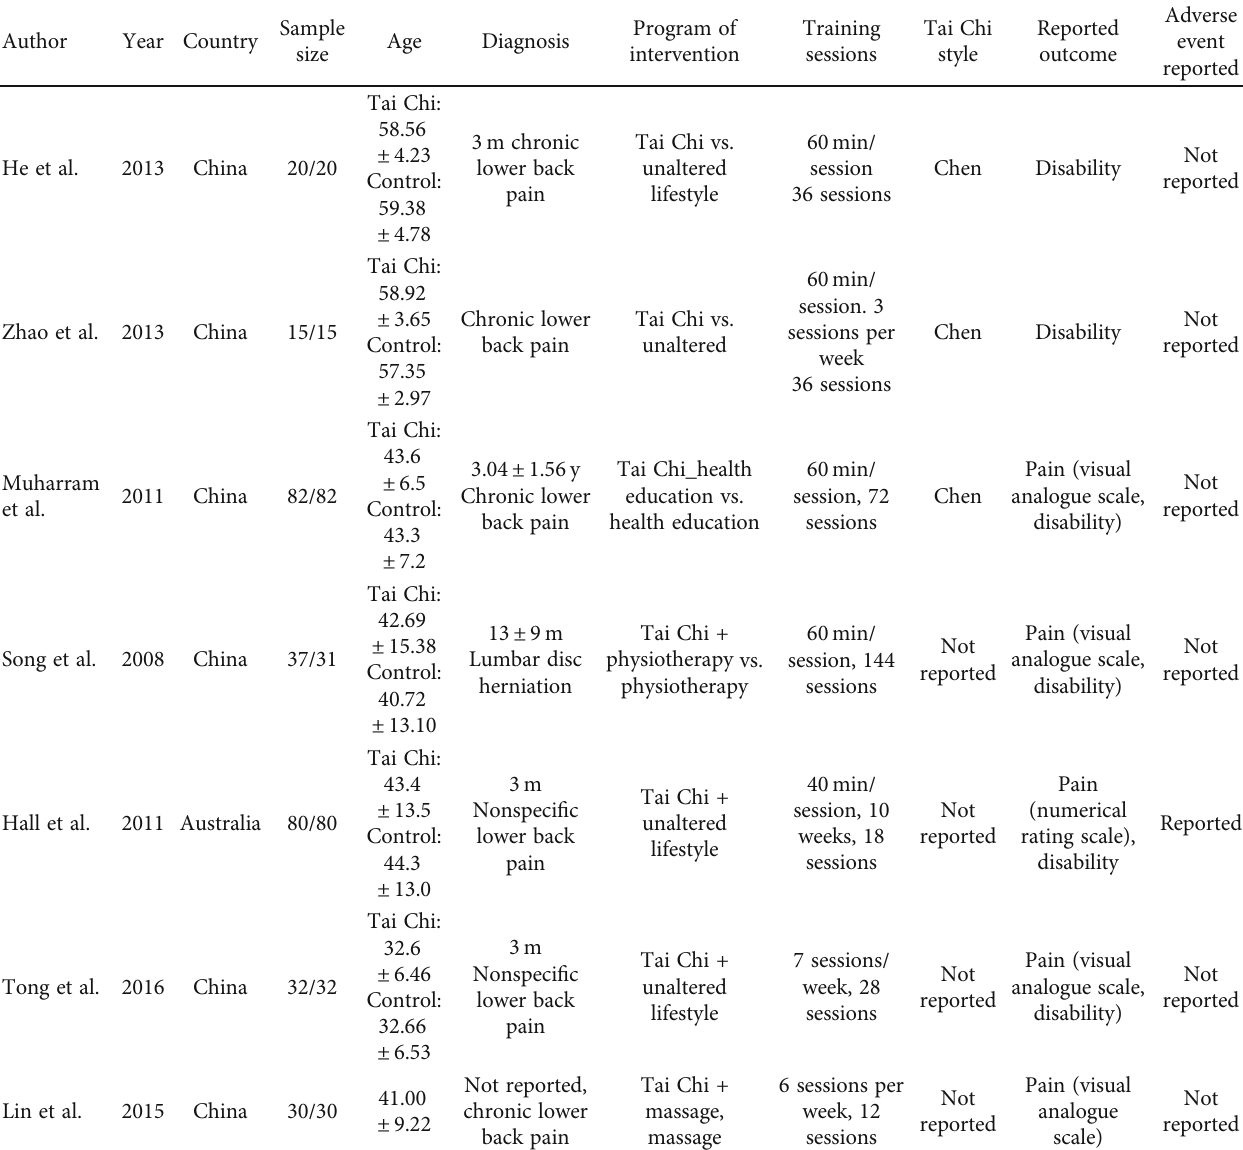
Table 1: Summary of the studies selected for meta-analysis.